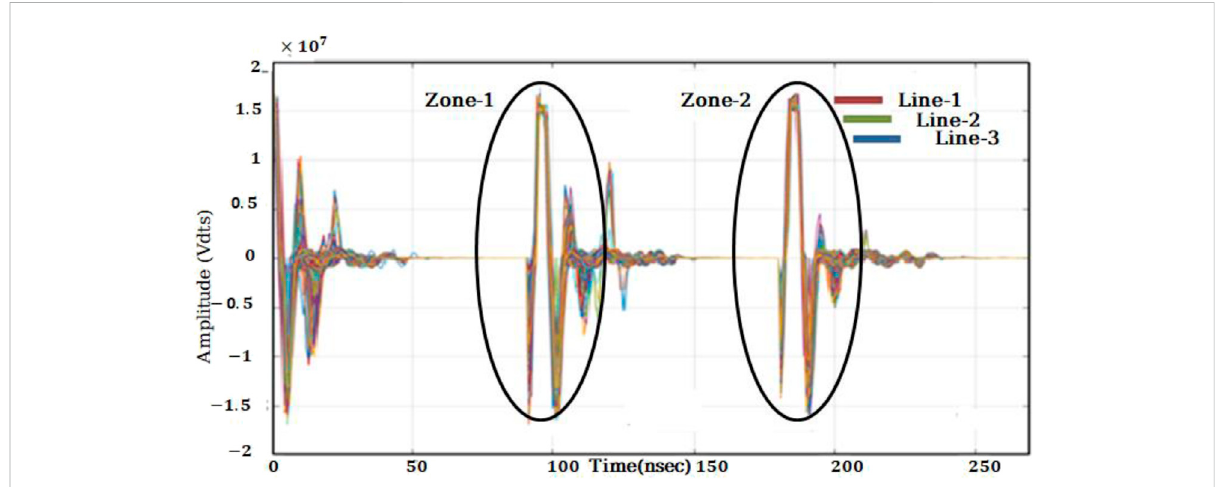
FIGURE 9 Transformed simulated signals at 100 MHZ frequency of combined three lines after editing in which time is included from 0 to 0.2 ns, which shows the maximum and minimum amplitude simultaneously, which is the anomaly of our study site Zone 1 and Zone 2 represent the anomalous body that is also called the target area of the test site.